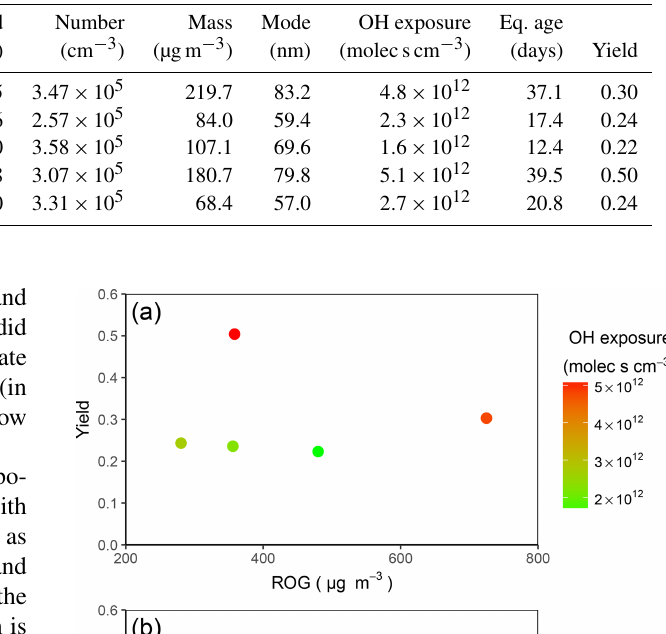
Table 1. Summary of the yield trials. D 5 reacted gas concentration represents the average of the upstream minus the average of the down- stream measurements. Number, mass, and mode represent the average SMPS aerosol values for the yield experiment period. Equivalent age represents the atmospheric aging assuming an OH concentration of 1.5 × 10 6 moleccm − 3 .